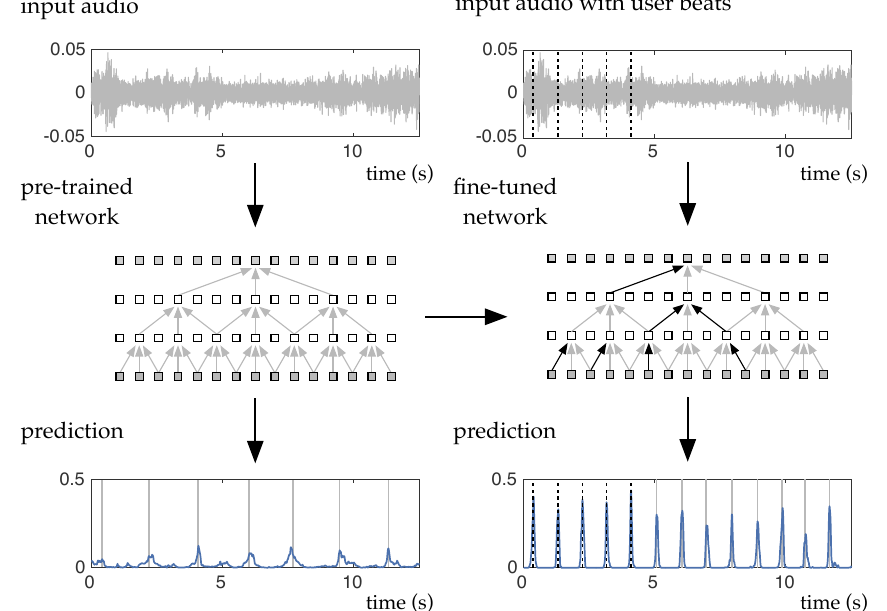
Figure 1. Overview of our proposed approach. The left column shows an audio input passed through a deep neural network (for consistency with our approach, this is a temporal convolutional network), which produces a weak beat activation function and erroneous beat output. The right column shows the same audio input, but here, a few beat annotations are provided as the means to fine-tune the network—with the black arrows implying the modification of some of the weights of the network. This results in a much clearer beat activation function and an accurate beat-tracking